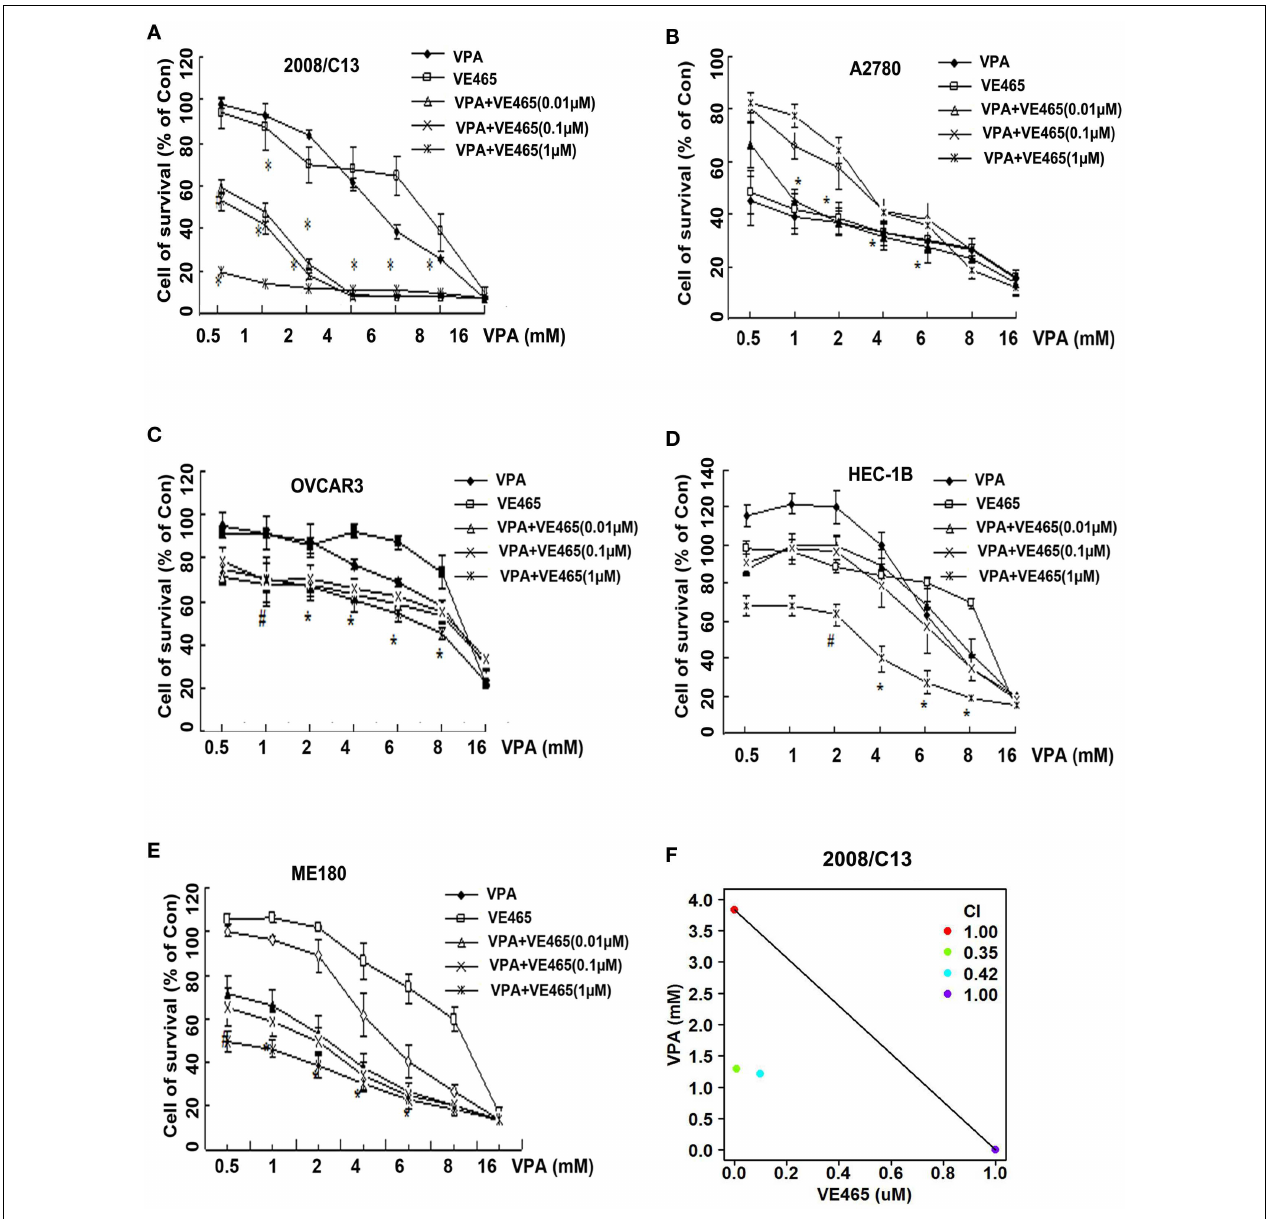
Isobologram analysis of the combined effects ofVE465 andVPA in 2008C13 cells. A combination index (CI) < 1 indicates a synergistic interaction, CI = 1 is additive, and CI > 1 is